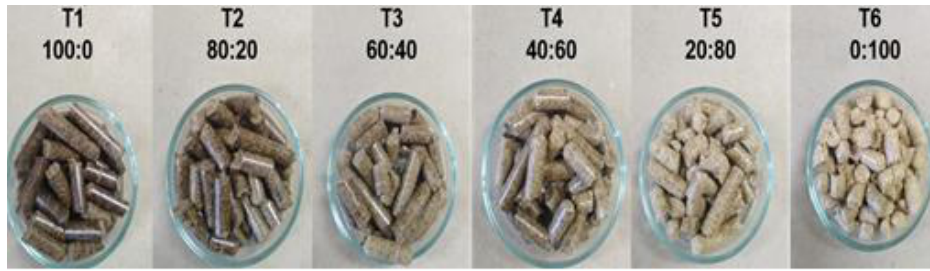
Figure 1. Colors taken by the pellets made with different mixtures of Agave durangensis fibers (T1) and Pine spp. sawdust (T6) [ Ti = Agave duranguensis fibers: Pinus spp. Sawdust].